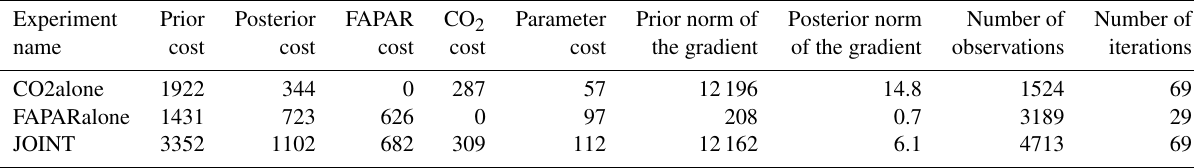
Table 3. Characteristics of the assimilation experiments. The prior and posterior cost-function values and the contribution of FAPAR, CO 2 and the prior (second term in Eq. 1) to the posterior cost-function value are given, as well as the norm of the gradient, the number of observations acting as a constraint, and the number of iterations of the assimilation Experiment